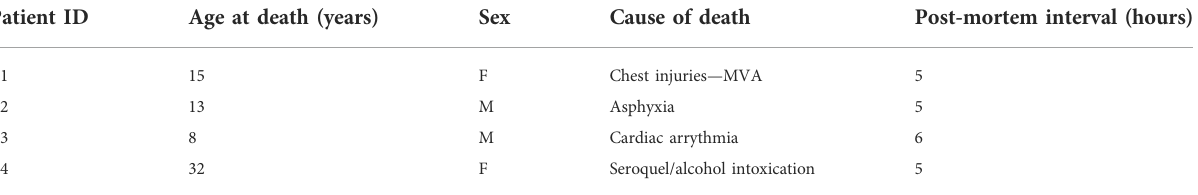
TABLE 2 Clinical information of control